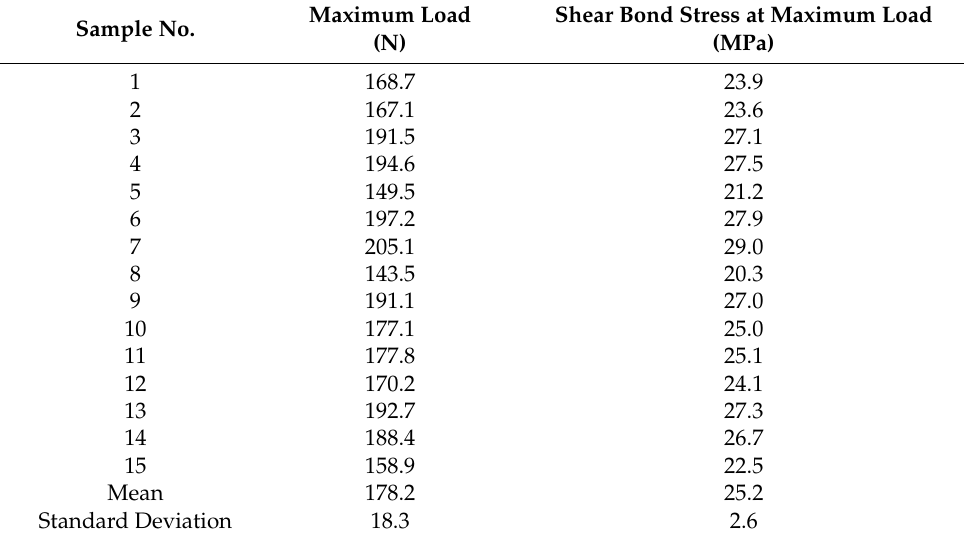
Table 3. Shear bond strength for Group II specimens ( n =